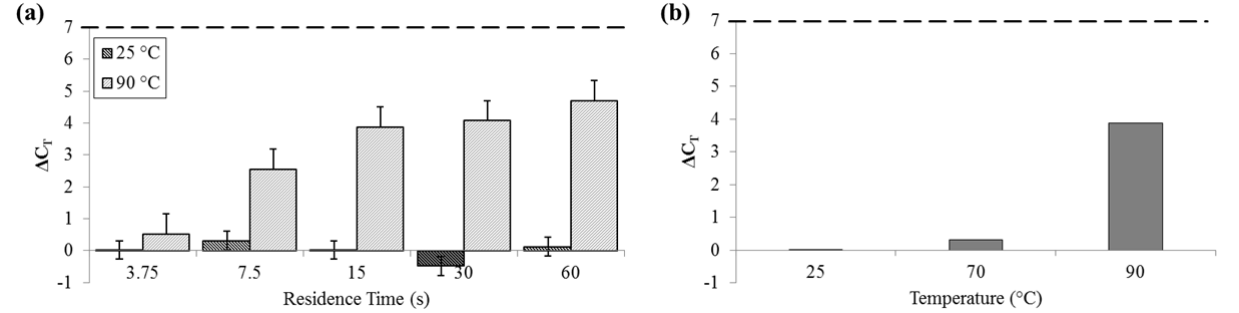
by qPCR compared to bead-beaten control (– – –). ( a ) For a range of Figure 6. Δ C T on-chip residence times from 15 to 60 s at room temperature (25 °C) and maximum heat (90 °C). ( b ) For three temperatures, each with a 15 s residence